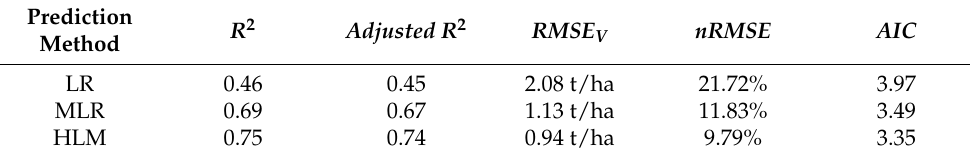
Table 7. Comparison of model precision of using LR, MLR, and HLM to predict maize yield.